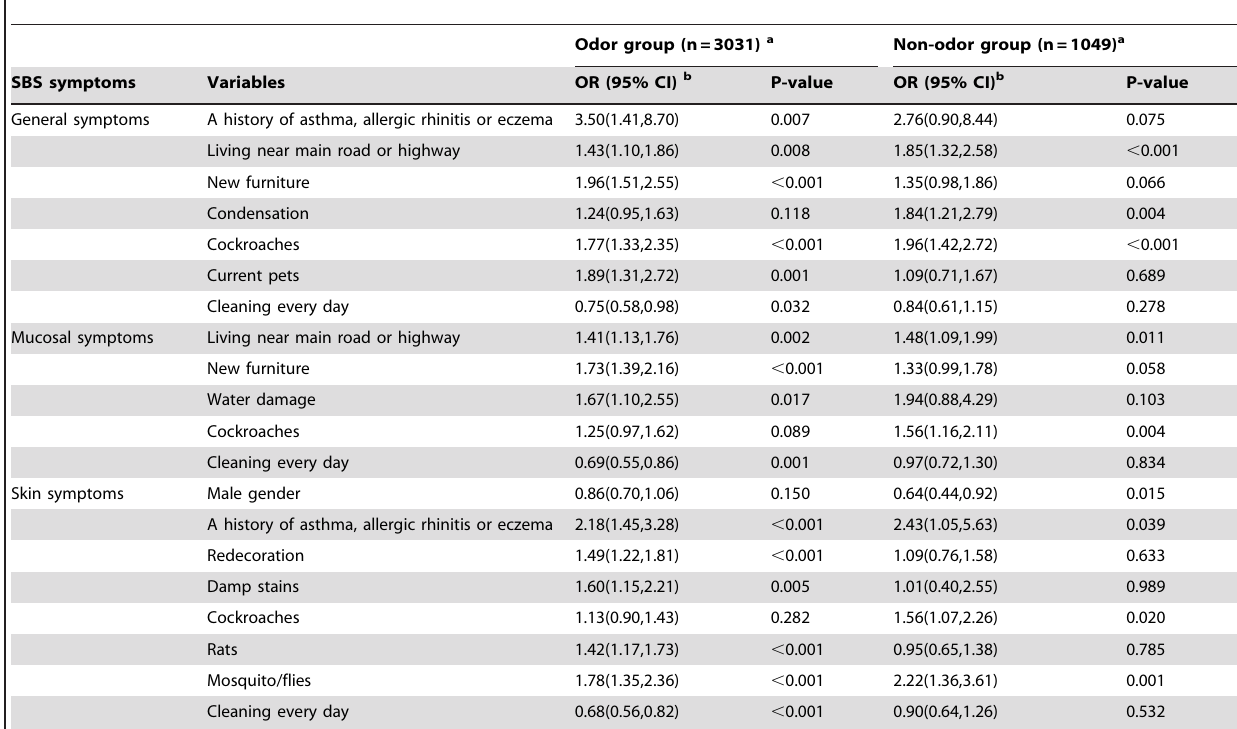
Table 10. Significant variables associated with SBS symptoms (weekly or sometimes), stratified for odor or humidity